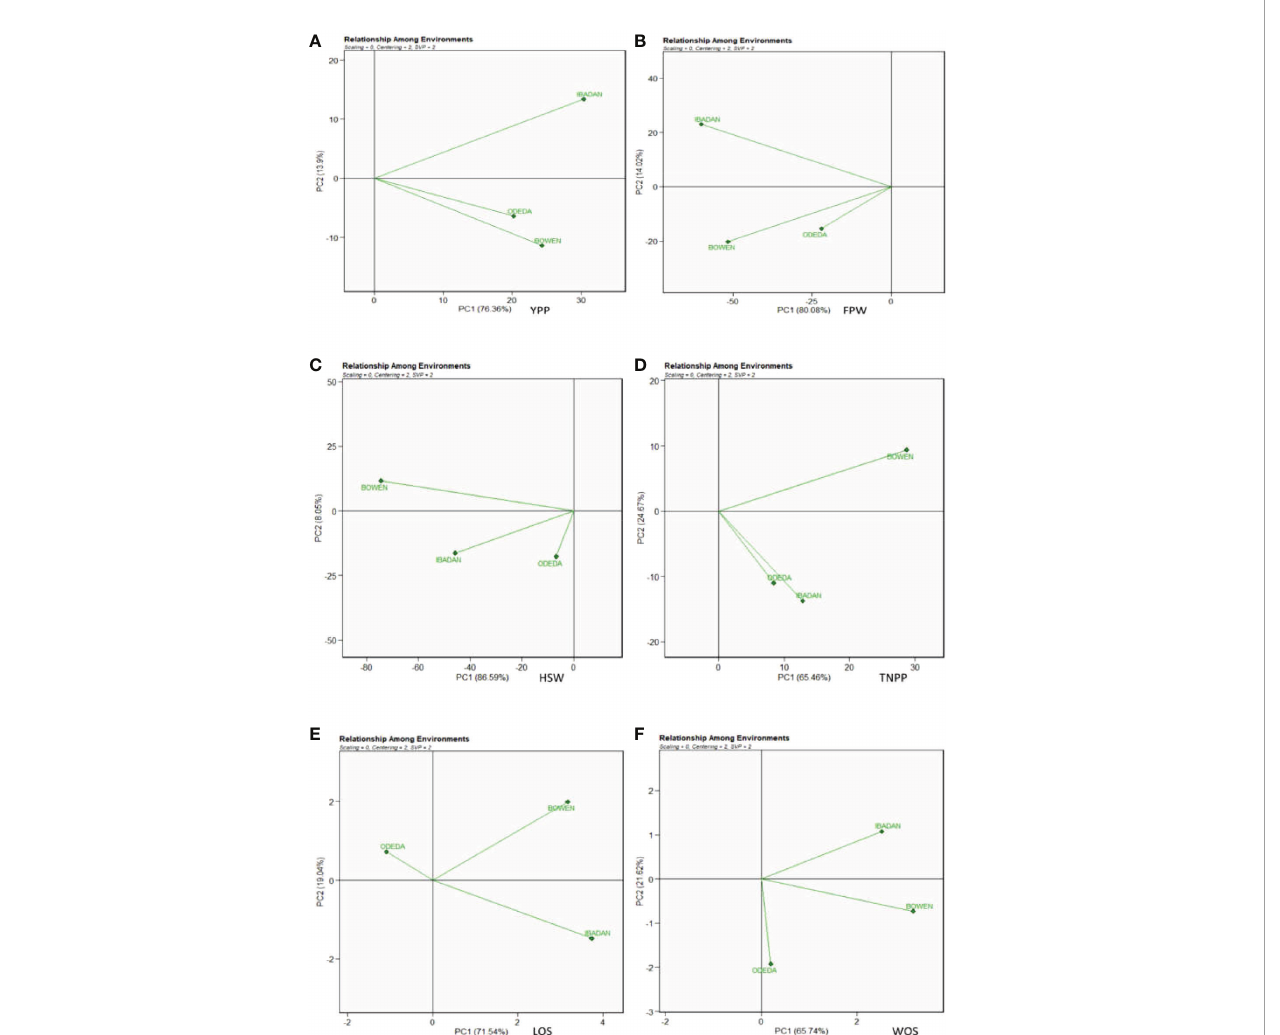
FIGURE 10 Patterns (A – F) . The relationship among environments tested for the production of 15 Bambara groundnut accessions with respect to (A) yield per plant (YPP), (B) fresh pod weight (FPW), (C) total no. of pods per plant (TNPP), (D) hundred seed weight (HSW), (E) length of seeds (LOS), and (F) width of seeds (WOS). The GGE biplot polygons were based on scaling = 0, centering = 2, and singular value partitioning (SVP) =